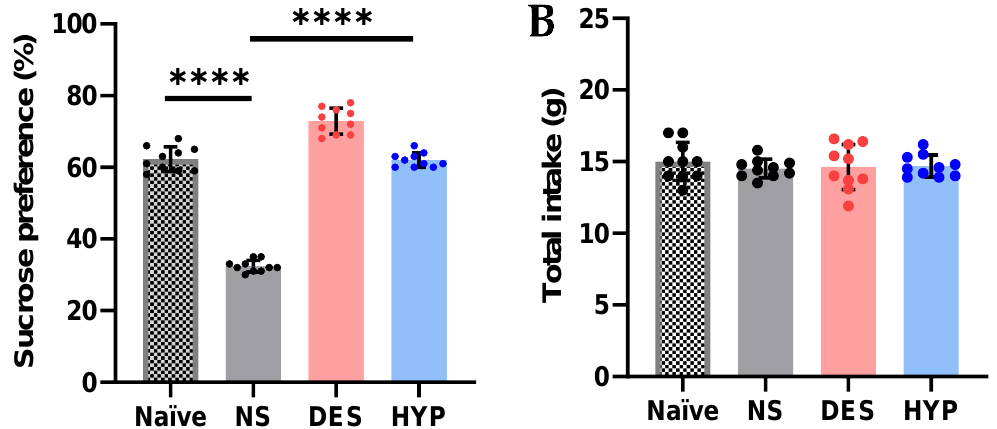
Figure 8. Effect of hypericin (F1) in increasing the preference of sucrose intake in the treated animals, compared to the control group, following chronic mild stress induction ( A ). This increase in preference to sucrose (%) is witnessed in the absence of any effect on total intake ( B ). Statistically significant assessed by an ordinary one-way ANOVA. Graph bars represent means ± SEM. **** p < 0.0001. ( n = 10 for each group). NS: normal saline, DES: desipramine, HYP: hypericin.